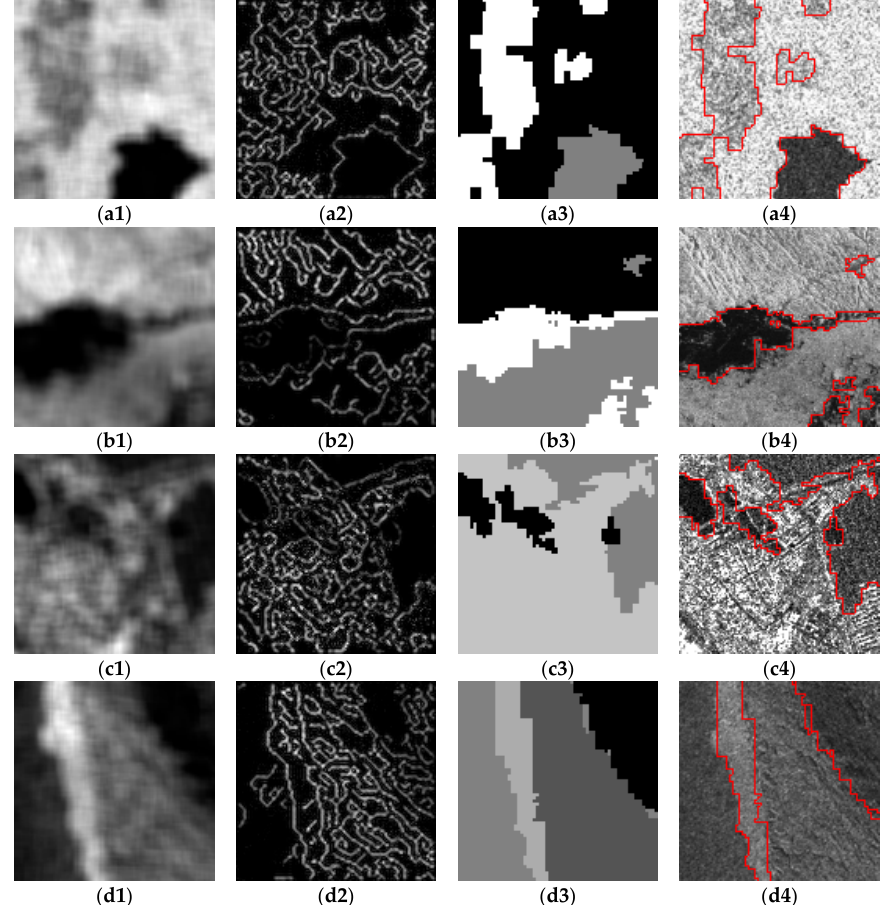
Figure 8. Results of real SAR images: ( a1 – d1 ) Texture features, ( a2 – d2 ) boundary features, ( a3 – d3 ) segmentation results, ( a4 – d4 ) overlaying the extracted outlines on the original